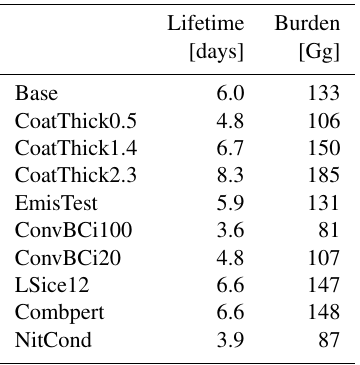
Table 2. Global BC lifetime and burden in each experiment. Lifetime Burden